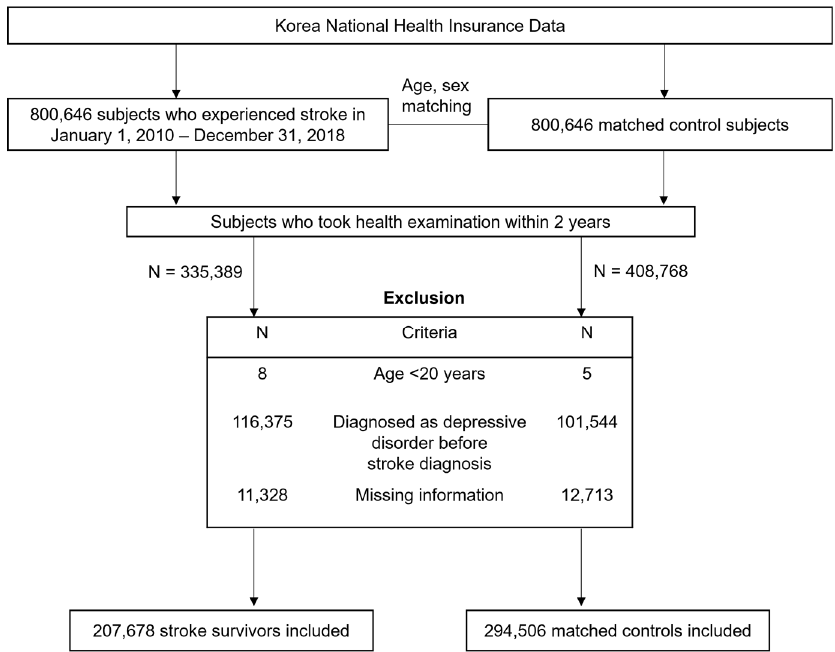
Figure 1. Flowchart of selecting study participants.